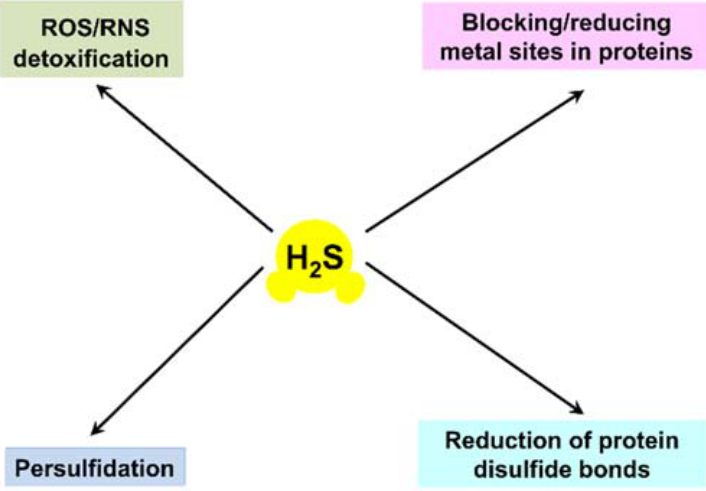
Figure 1. Proposed H 2 S signaling mechanisms in mammalian systems.